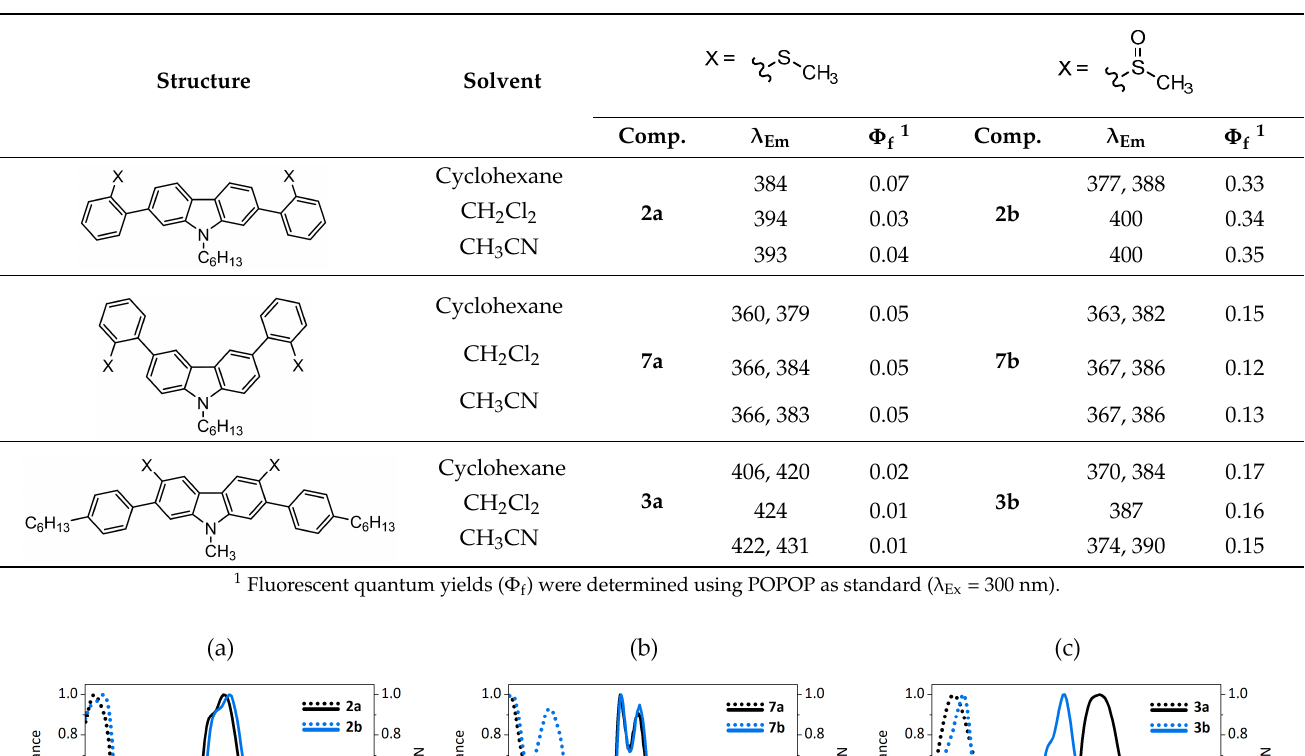
Table 1. Photoluminescent characteristics of the sulfurated molecular structures 2 , 3 and 7 in different solvents.